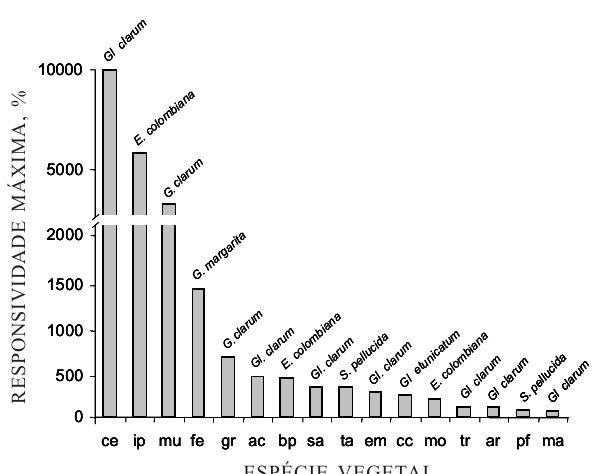
Figura 4. Responsividade máxima da planta - RMP da planta e respectivo isolado. ce - cedro; ip - ipê; mu - mutamba; fe - fedegoso; gr - gravitinga; ac - açoita-cavalo; bp- bico-de-pato; sa - sabiá ta - tamboril; em- embaúba; cc - cássia-carnaval; mo - moreira; tr - trema; ar - aroerinha; pf - pau-de- ferro; ma - maricá.